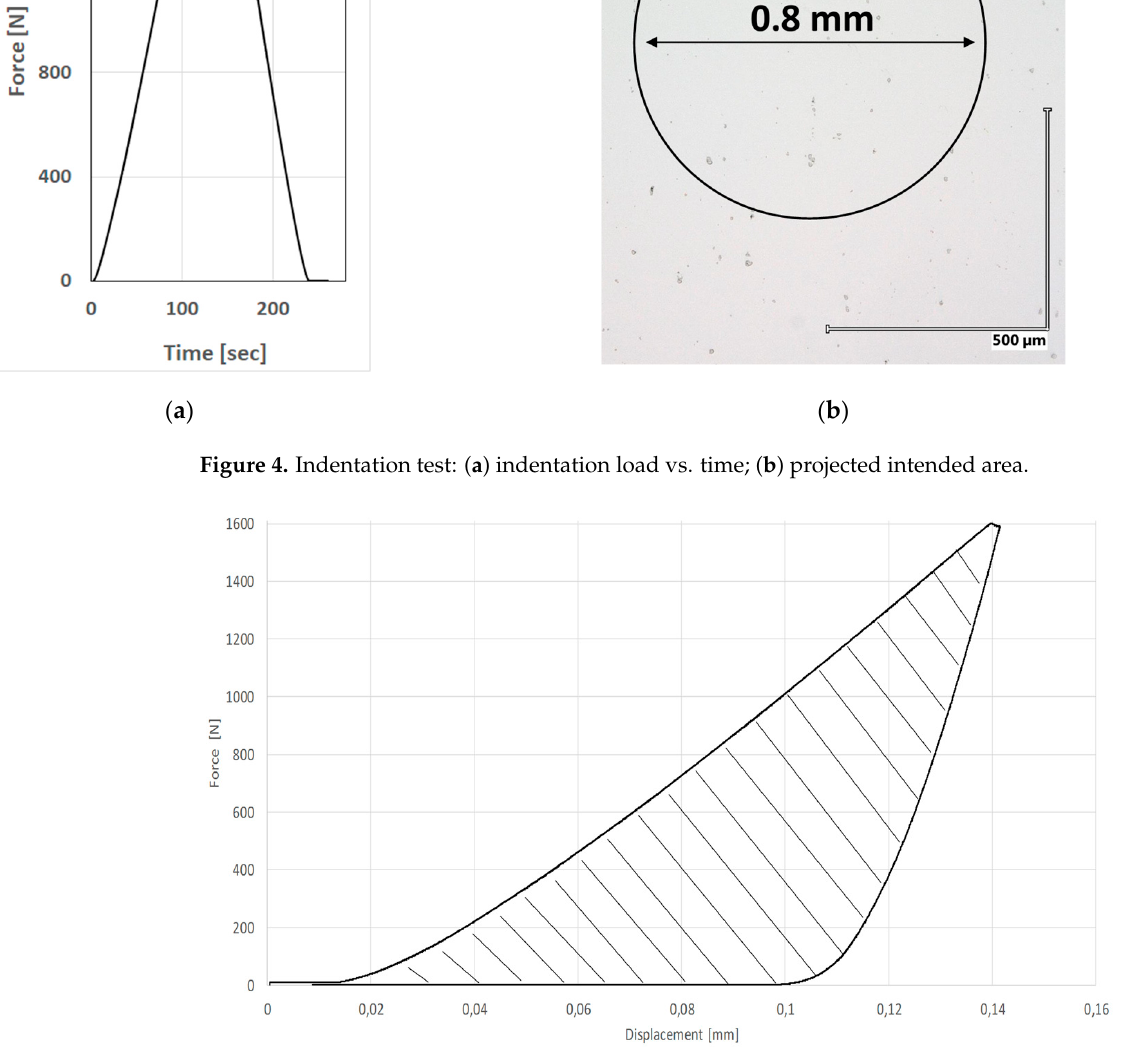
Figure 5. Force–displacement plot for indentation test.